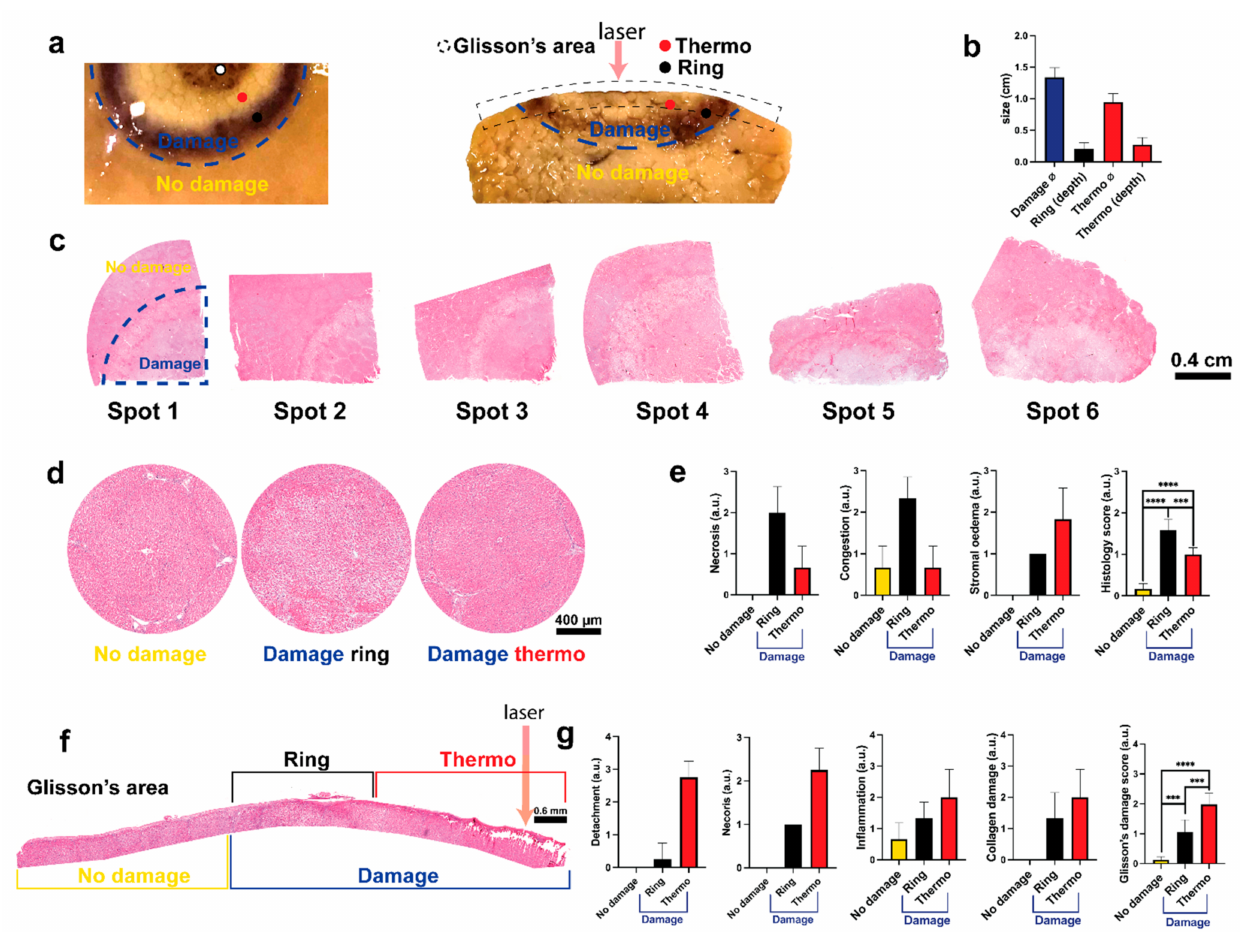
Figure 5. ( a ) Figure target of the biopsy, frontal and intraparenchymal view. Two classes, “damage” and “no damage”, are visible. Within the “damage” class it is possible to observe two classes: one homogeneous called “ring” and one heteroge- neous called “thermo” composed by a white area visible in both views and one by a carbonization which characterizes only the Glisson’s area. ( b ) Descriptive analysis of the damage size. ( c ) Frontal view of all the spots. Spots 1 to 4 pig 1, spots 5 and 6 for pig 2. The margin of the damaged area is visible accordingly with the figure target. ( d ) Macro of the 3 main classes reconstructed with 5 to 10 images 10 × . Compared with the “no damage” area, “ring” and “thermo” present a reperfusion and ischemic damage given by the heating transferred by the laser from the Glisson’s to the parenchyma in a radial fashion. ( e ) Histology score of the parenchymal view. Necrosis, congestion, and stromal oedema are displayed separately and their averages with the sinusoidal dilatation are shown on the right. The three areas are statistically different. ( f ) Glisson’s area map reconstructed with 9 images 10 × . “Thermo” class presents a visible detachment with coagulative necrosis and superficial carbonization of the collagen and parenchyma. ( g ) Score of the Glisson’s area. Detachment, necrosis, inflammation, and collagen damage are shown separately. Glisson’s damage score represents the average with mesothelium damage. The three areas are statistically different. One-way ANOVA was used. Data are presented as mean ± s.d. and compared to the control, two tailed p -value p ≤ 0.05 was considered statistically significant, *** p ≤ 0.001, **** p ≤ 0.0001. N = 6 (ROIs in 2 pigs). Pictures sampled with microscope Zeiss AXIO scope